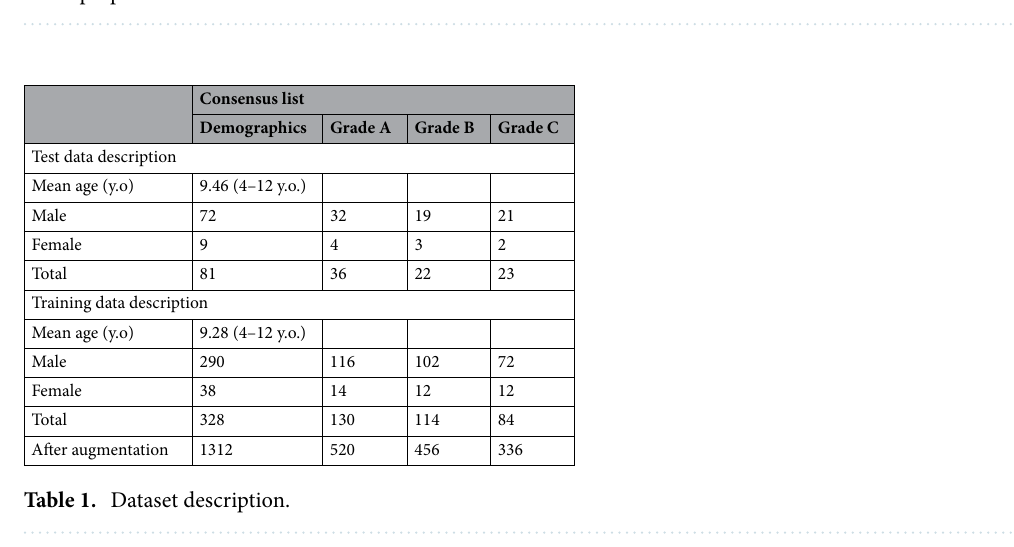
Figure 1. A flowchart of training and test progress ( a ) All normal and LCPD hips collected ( b ) Obtaining normal pediatric hip radiographs (328 images) that are representative of the real patient group in terms of age and gender distribution ( c ) Randomly selected 130 images from 328 normal images to create group A. ( d , e ) 114 images for group B and 84 images for group C modified by computer engineers under the guidance of six orthopedists ( f ) Augmenting the modified images to 1312 for training (520 in Class A, 456 in Class B, and 336 in Class C). ( g ) Designing CNN’s architecture and saving the CNN model for the test process ( h ) Obtaining real patients’ (LCPD) hip X-ray images (81 images). ( i ) Labelling LCPD patients’ hip radiographs with a unanimous decision by 6 senior orthopedists (Class A:29, Class B:31, Class C:21). ( j ) Applying the trained CNN model to test images and transferring the obtained classification results to the evaluation stage. ( k ) Testing the reliability of the proposed method and decision of the 6 doctors.